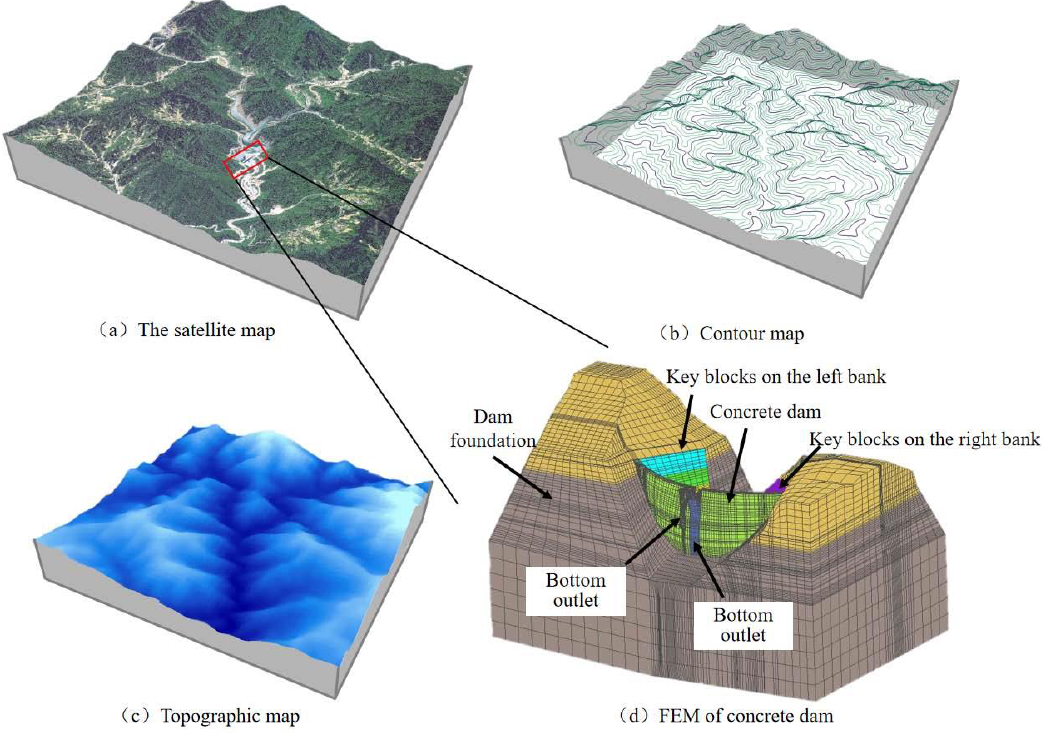
Figure 5. Location of the concrete arch dam and its FEM model.